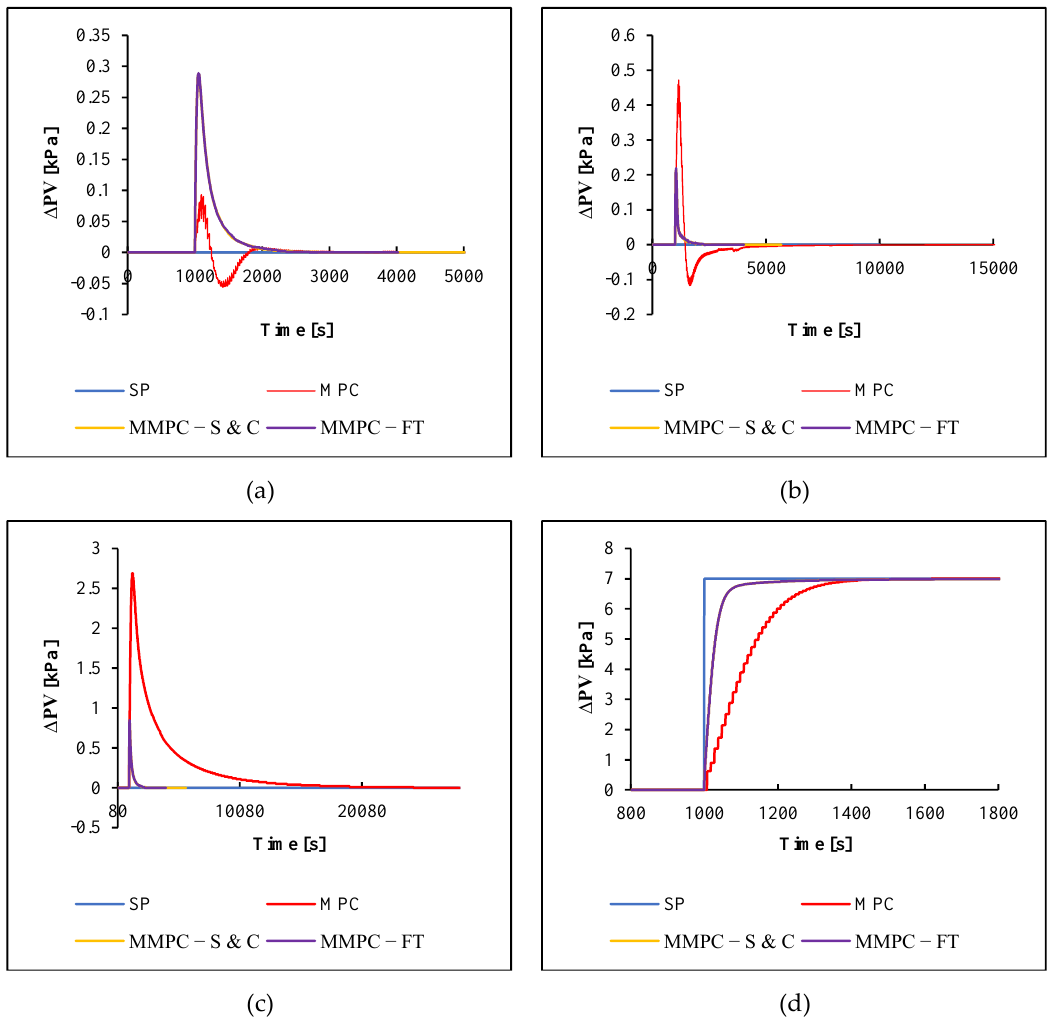
Figure 6. Comparison of controller performance with SP changes on compressor unit 4 (MIMO Model 1) on: ( a ) compressor unit 1; ( b ) compressor unit 2; ( c ) compressor unit 3; and ( d ) compressor unit 4. Table 7. Comparison of IAE and ISE on compressor units with changes on compressor unit 1 (MIMO Model 1).